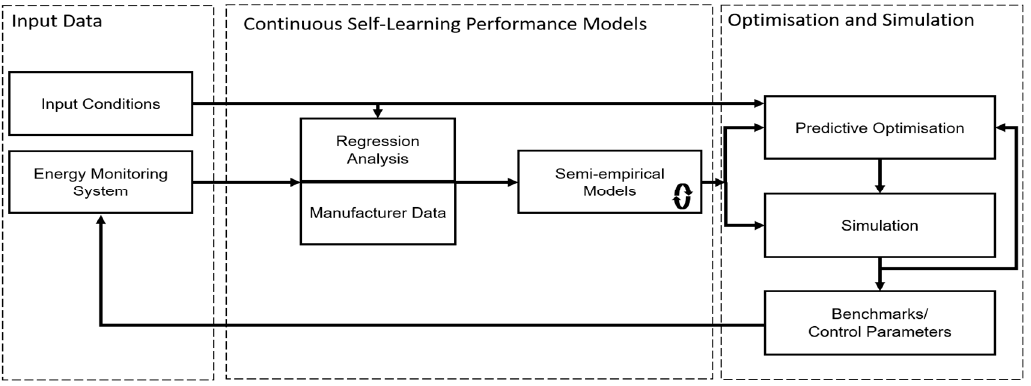
Figure 1. Simulation-based optimization Figure 1 . Simulation-based optimization scheme .